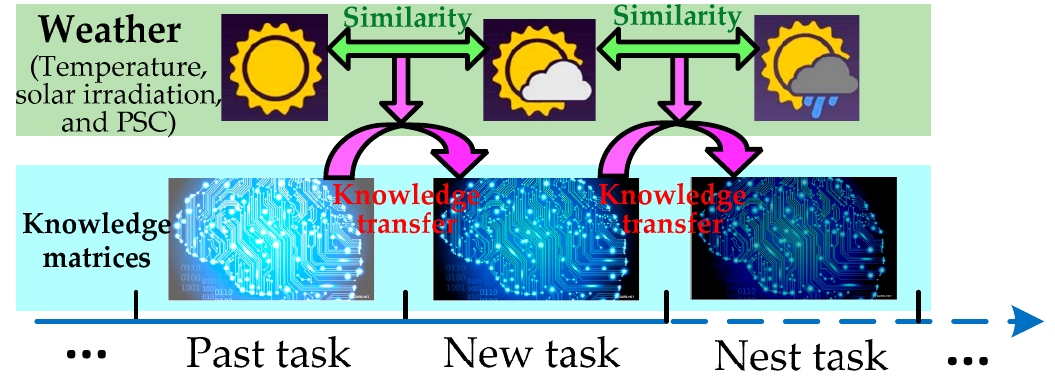
Figure 3. Knowledge transfer of TRL between two adjacent tasks for maximum power point tracking (MPPT) with PSC.